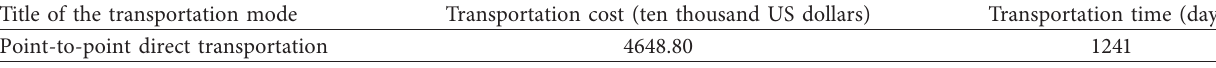
Table 13: Relationship between non-hub and hub when using function f